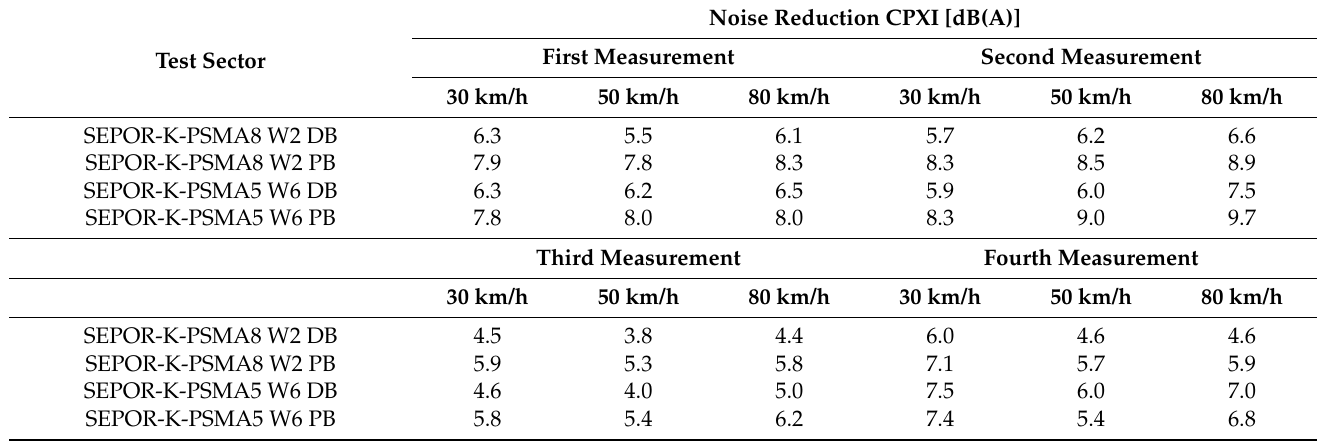
Table 10. Noise reduction of poroelastic mixtures on the Kartoszyno long test section.